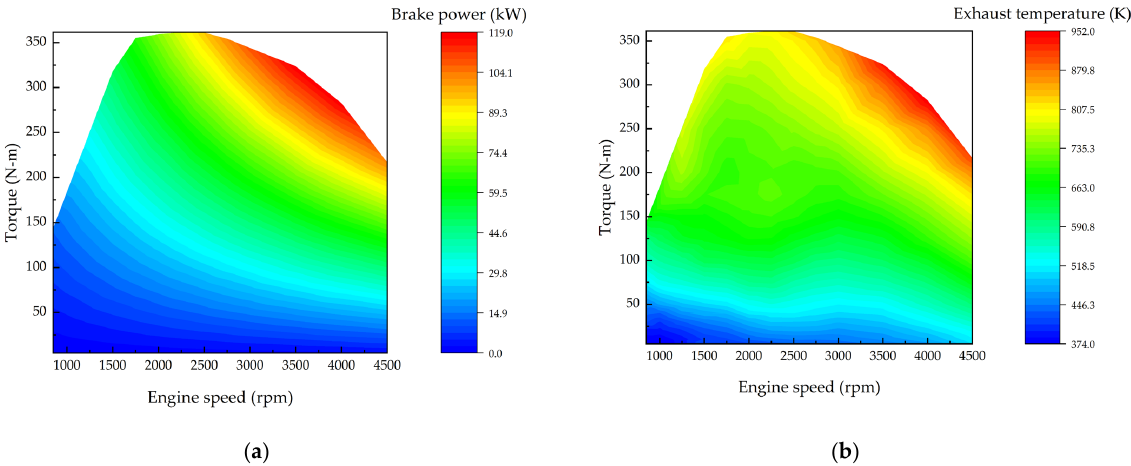
Figure 1. Diesel engine MAP: ( a ) engine brake power; ( b ) engine exhaust temperature.